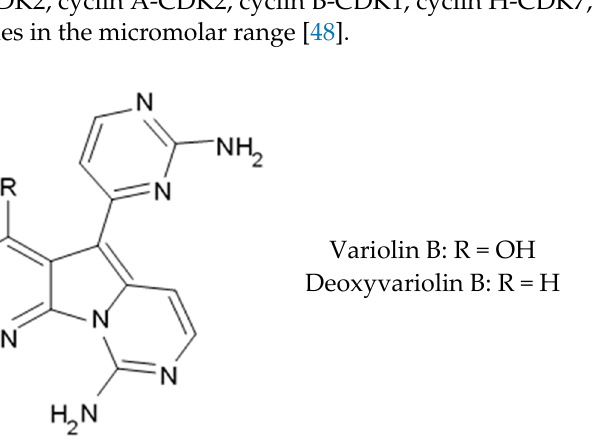
Figure 2. Chemical structure of variolin B and deoxyvariolin B.